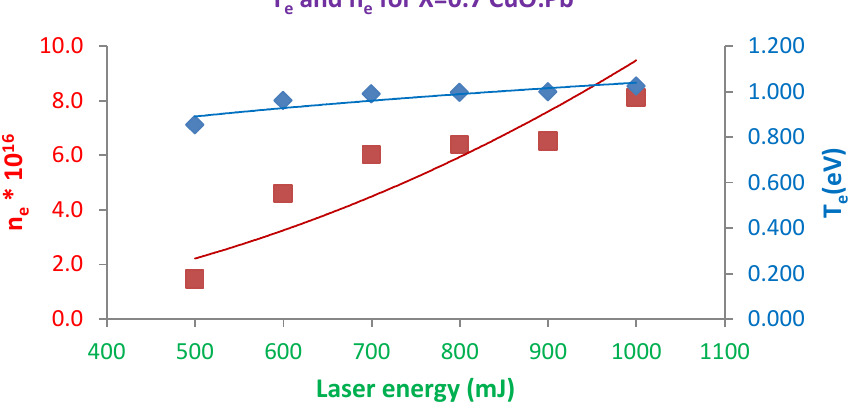
Fig. 7: The variation of (T